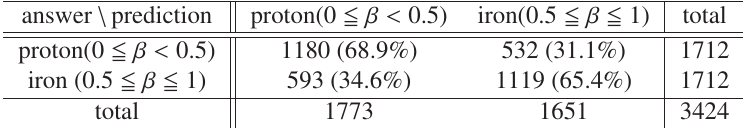
Table 3: Classification matrix for all test data in Fig. 7. The percentage of cosmic-ray events considered to be of proton origin if the output value β is less than 0.5, and of iron origin if the output value is greater than 0.5, is shown in